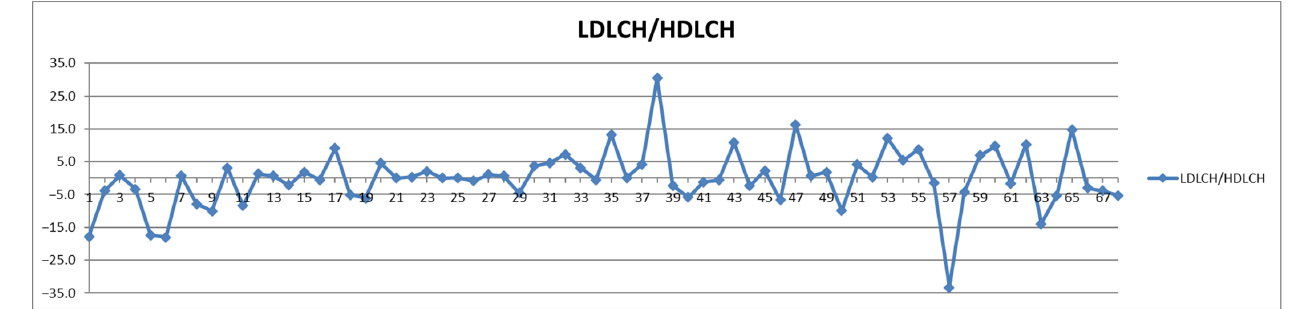
Figure 11. LDL/HDL cholesterol ratios in fasting and postprandial status in fasting (blue) and post-